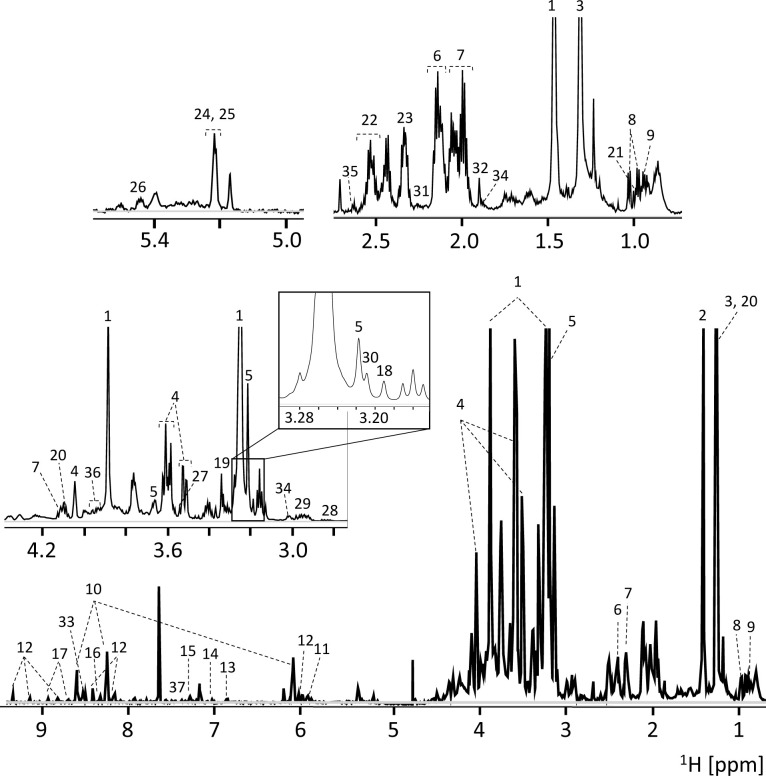
Typical 600 MHz 1H-NMR spectrum of Schistosoma extract obtained in H2O.1: Betaine; 2: Alanine; 3: Threonine; 4: myo-Inositol; 5: sn-Glycero-3-phosphocholine (3GPC); 6: Glutamine; 7: Proline; 8: Valine; 9: Isoleucine; 10: AMP; 11: UDP-N_Acetylglucosamine; 12: NAD+; 13: Tyrosine; 14: Histidine; 15: Tryptophan; 16: Adenosine; 17: Niacinamide; 18: Choline; 19: Methanol; 20: Lactate; 21: Leucine; 22: Gluthatione; 23: Glutamate; 24: Glucose; 25: Glucose-1-phosphate; 26: Glucose-6-phosphate; 27: Glycine; 28: Aspartate; 29: Asparagine; 30: O-Phosphocholine; 31: Succinate; 32: Acetate; 33: ADP+ATP; 34: Lysine; 35: Methionine; 36: Serine; 37: Phenylalanine.